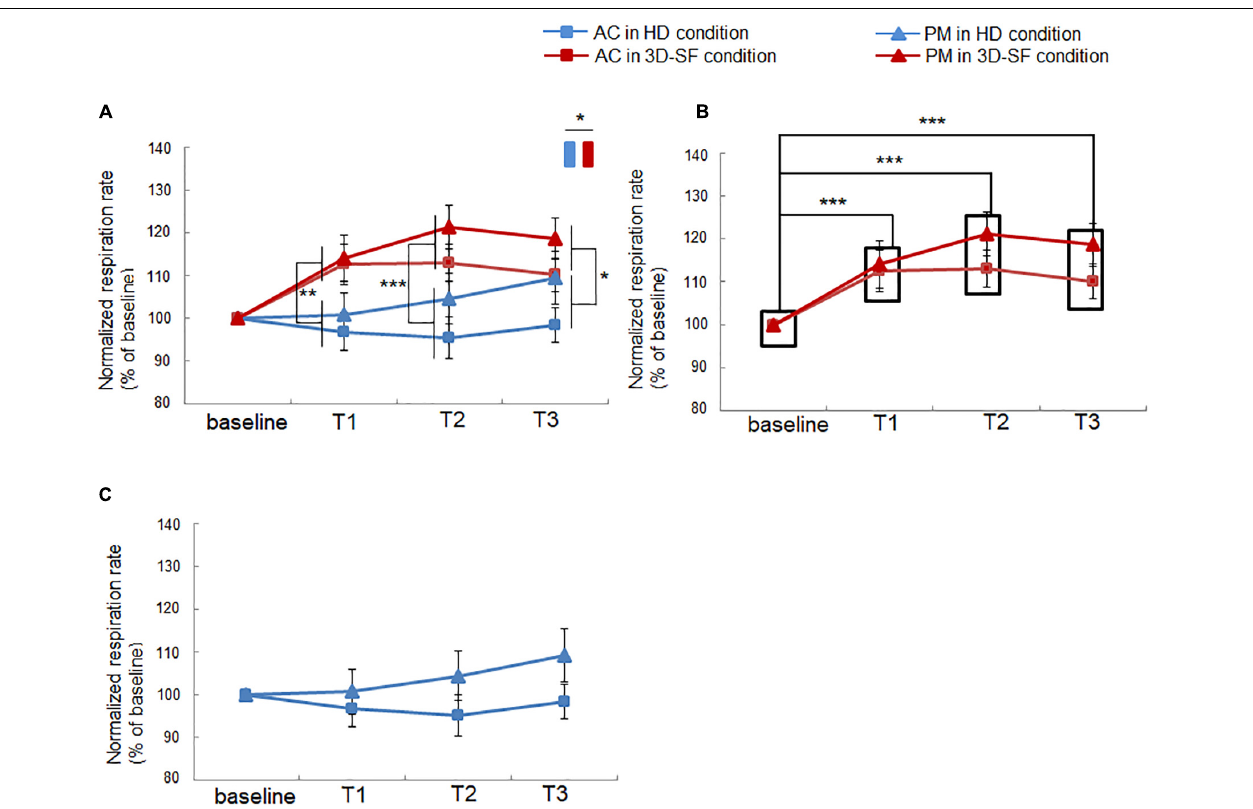
FIGURE 5 | Effect of music listening on normalized respiration rate. (A) Comparison between the HD and 3D-SF conditions. (B) Comparison among the four time regions (baseline, T1, T2, and T3) in the 3D-SF condition. (C) Comparison among the four time regions (baseline, T1, T2, and T3) in the HD condition. Data are presented as means ± SEM; *** p < 0.001, ** p < 0.01, * p <